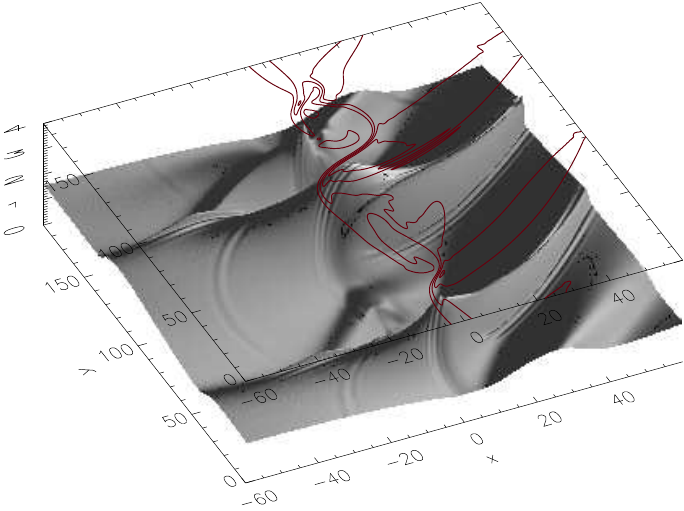
Figure 4. Total pressure P T (gray color) in the ( x , y ) -plane with overplotted density isocontour lines (red color) at t = 182 for the case V 0 = 7. The density isocontour evidences the shape of the vortices in the middle of the box and the pressure perturbations put in evidence the emission of fast waves from the shear layer and the shock structures that extend in both sides of the box.